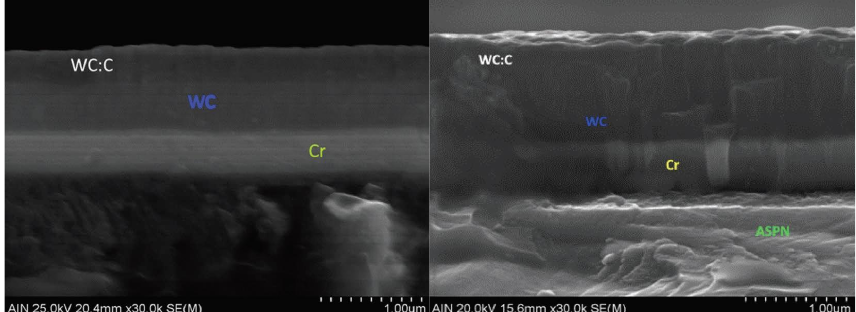
Figure 1: Cross section SEM picture with the coating’s structure of DLC WC:C (a) and ASPN 400 ° C +DLC WC: C (b). From the bottom to top, the image shows the stainless-steel substrate, the bonding layer of Cr, the WC interlayer, and the W-doped layer.